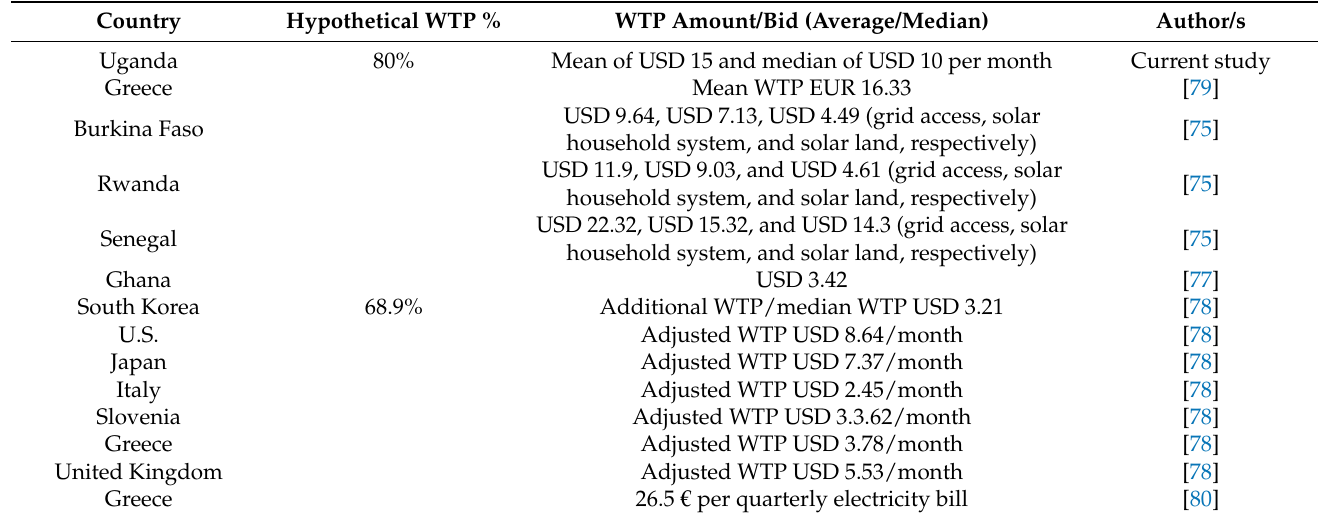
Table 6. WTP estimates’ comparison of the current study with previous studies from diverse